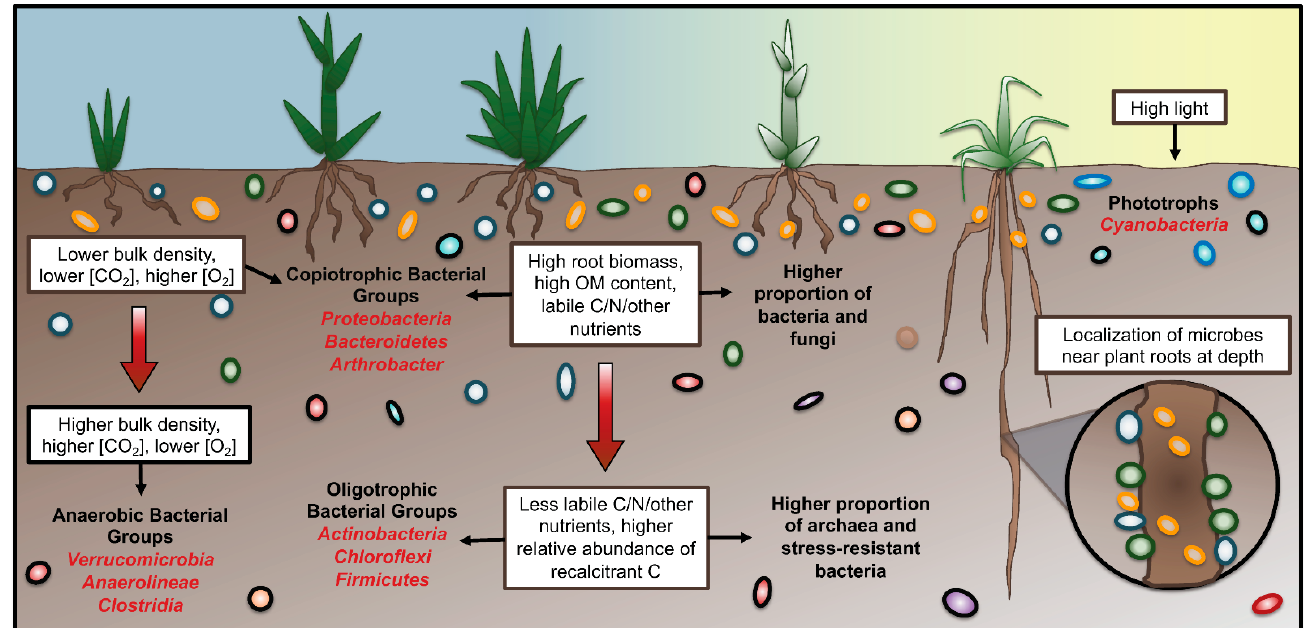
Figure 1. The effects of soil depth on soil properties and microbial groups. With depth, there is greater compaction and higher bulk density that decrease the oxygenation of subsoils, as well as prevent carbon dioxide from exchanging with the atmosphere. Together, these lead to the proliferation of anaerobic microbial groups in subsoils ( left ). At surface levels, there are higher contents of nutrients and labile C from sources such as decomposing plant OM and root exudates. These favor high microbial biomass and diversity, especially for copiotrophic bacterial groups, as well as overall levels of fungi and bacteria ( top middle ). However, in subsoils, the contents of labile C and nutrients go down due to fewer inputs from plants and other sources, leading to more nutrient-poor and extreme conditions which favor archaea and stress-resistant bacteria. Furthermore, much of the available C is in recalcitrant forms, which favors oligotrophic bacteria ( bottom middle ). The few fresh inputs of labile C tend to be around plant roots or soil cracks, so bacteria tend to be localized to these areas ( bottom right ). In addition, high light availability at the soil surface is conducive to phototrophic groups ( top right ).